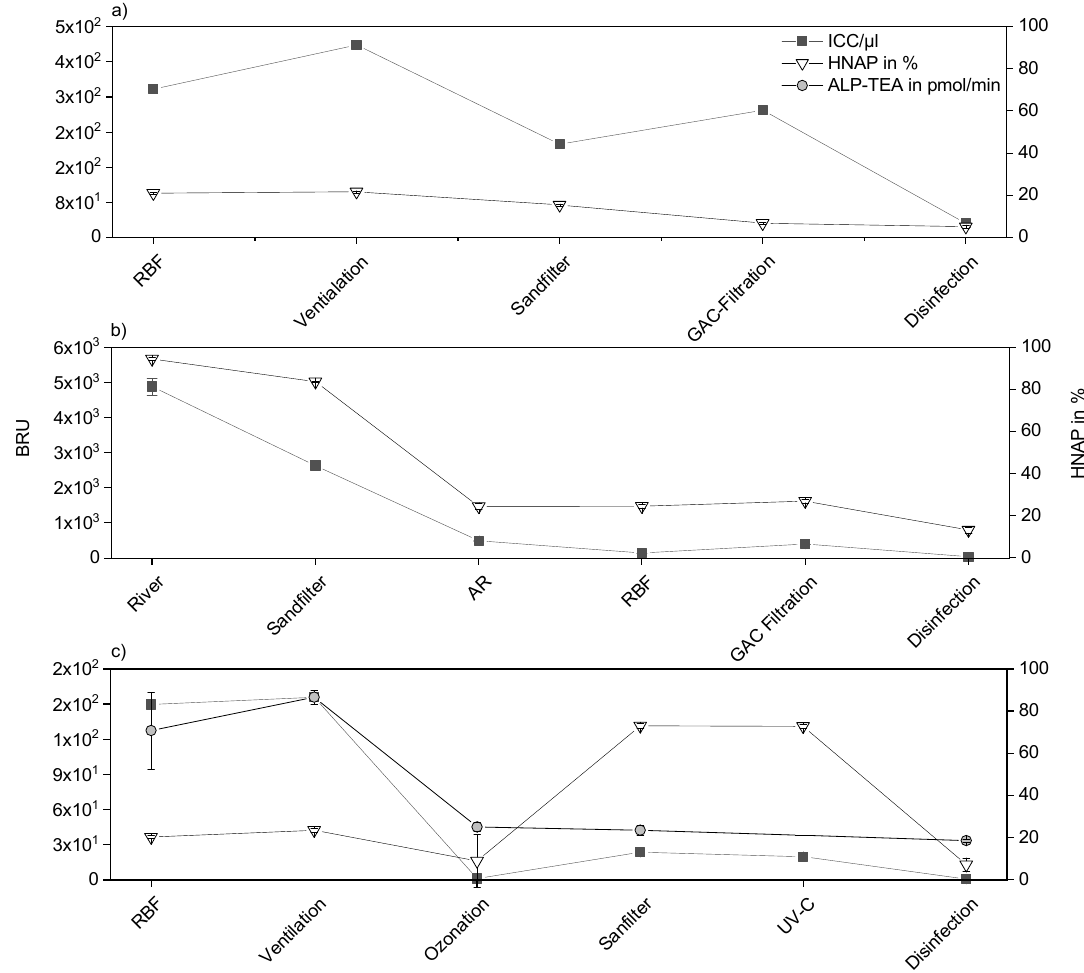
Figure 3. Comparison of FCM intact cell count in ( a ) D2, ( b ) D1 and ( c ) CI, (ICC, n = 5) with total enzymatic activity (ALP-TEA, n = 3 only CI), Sampling Dates: 9 May 2019 (CI), 15 May 2019 (D2) and 5 June 2019 (D1), FCM samples were stained with SYBER® Green and propidiumiodide, error bars representing standard deviation for those points.